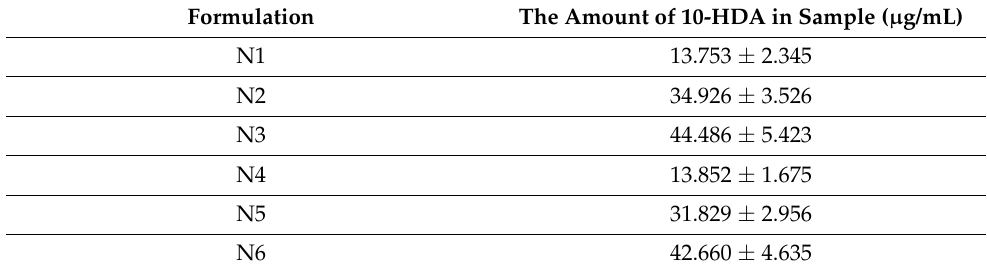
Table 5. The amount of 10-HDA in microemulsions evaluated using an HPLC